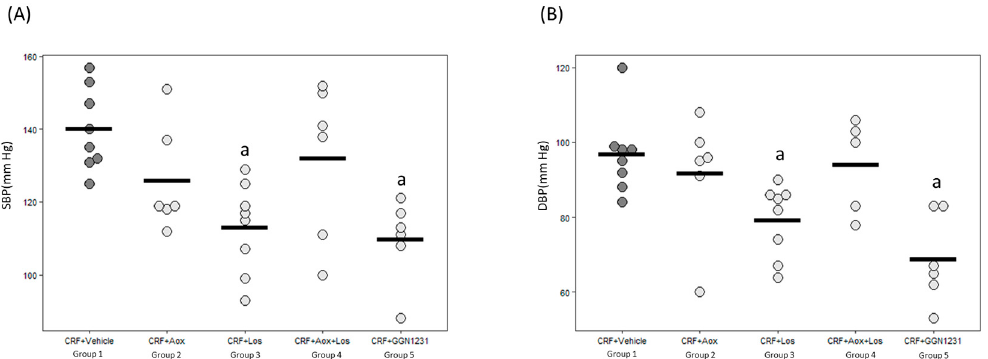
Figure 3. ( A ) Systolic (SBP) and ( B ) diastolic (DBP) blood pressure. CRF (chronic renal failure); Aox (antioxidant); Los (losartan); Aox+Los (antioxidant plus losartan); GGN1231 (antioxidant plus losartan hybrid). Data represent mean values per group in horizontal lines in the bee swarm graphic. a p < 0.05 versus CRF+vehicle.